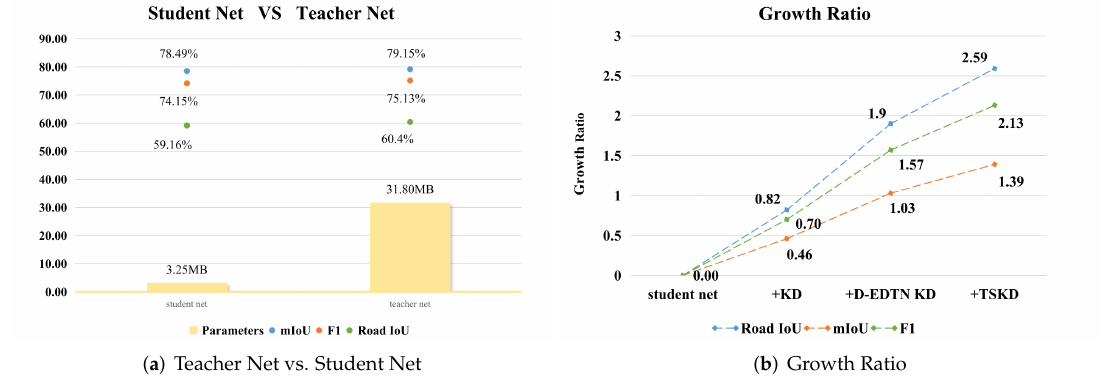
Figure 11. Segmentation results of our method, the topological space network for road extraction based on knowledge distillation (TSKD-Road), with the Massachusetts Dataset. ( a ) Comparison of the performance of the student net and the teacher net (D-EDTN) with different parameters in Road IoU, mIou, and F1 score. ( b ) The growth ratio of evaluation metrics includes Road IoU, mIou, and F1 scores between our proposed methods and the